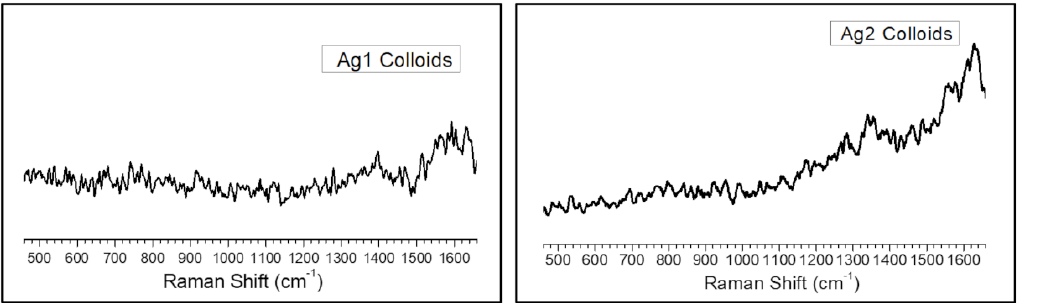
Figure A2. Scanning Electron microscopy (SEM) images were recorded at 5 kV (Scale bar, 200 nm) using Zeiss instrument. ( A ) SEM image aggregated citrate reduced nanoparticles (Ag1 + KCl + HCl) and ( B ) SEM image of aggregated sodium borohydride reduced nanoparticles (Ag2 + KCl + HCl).